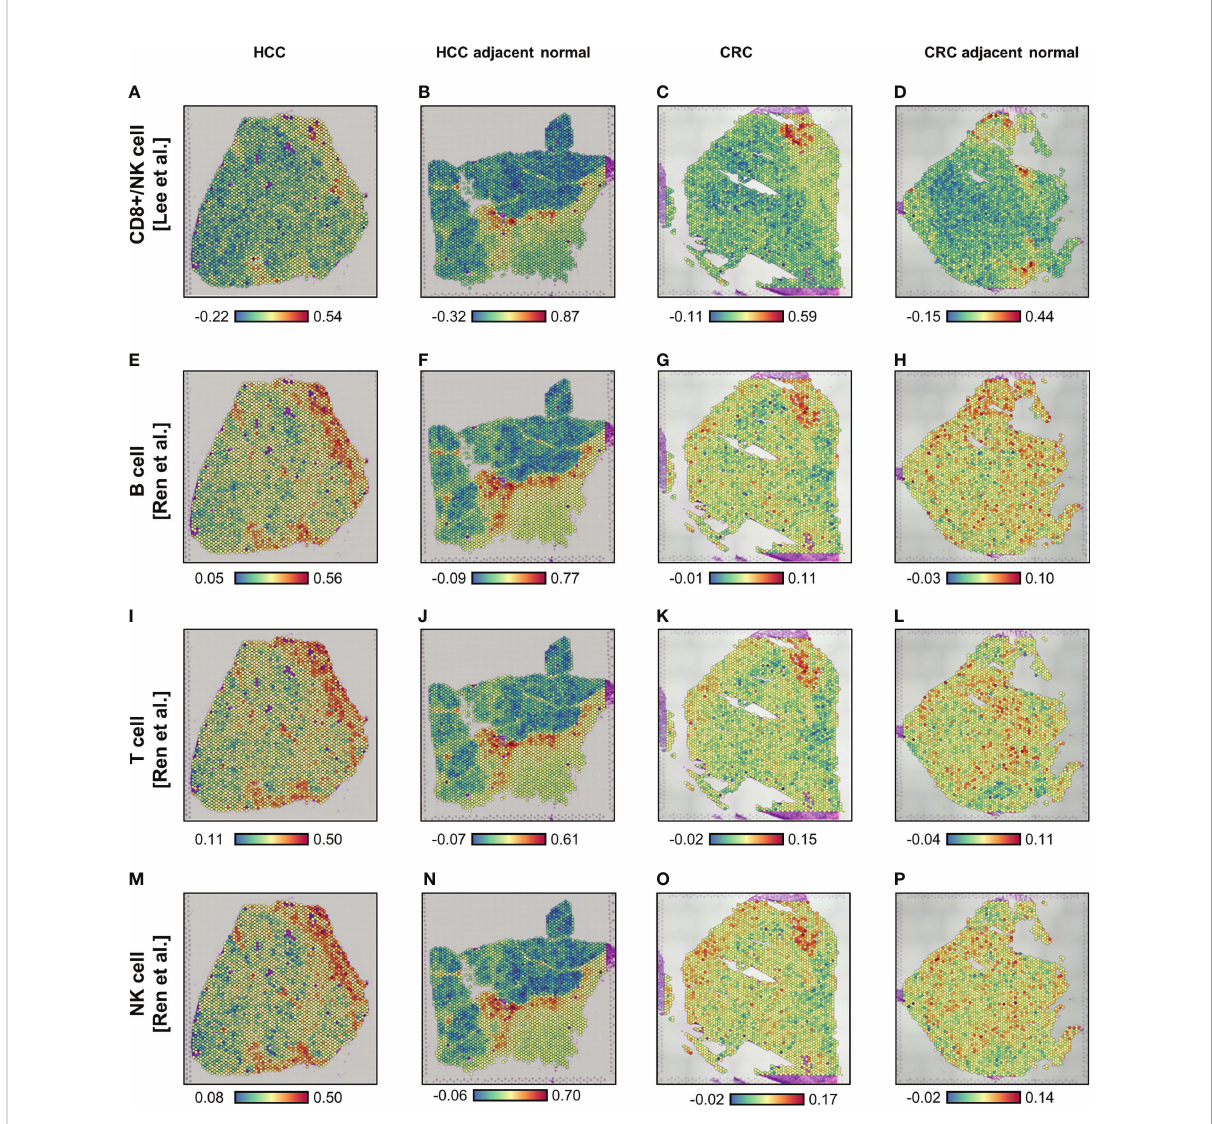
FIGURE 1 Spatial enrichment of COVID immune response signatures in biopsied HCC and CRC tissues from COVID-19-recovered patients. (A – P) Visium-based (10× Genomics) spatial transcriptomics-generated tissue heat maps show the spatial localization of COVID immune responses in HCC (A, E, I, M) and CRC (C, G, K, O) tumors and their adjacent normal tissues ( B, F, J, N , D, H, L, P , respectively). Analysis was based on lymphocyte-associated COVID immune response gene signatures (Lee et al. (15), A – D ; and Ren et al. (16), E – P ): CD8 + T/NK cells-associated (A – D) , B cell-associated (E – H) , T cell- associated (I – L) , and NK cell-associated (M – P)